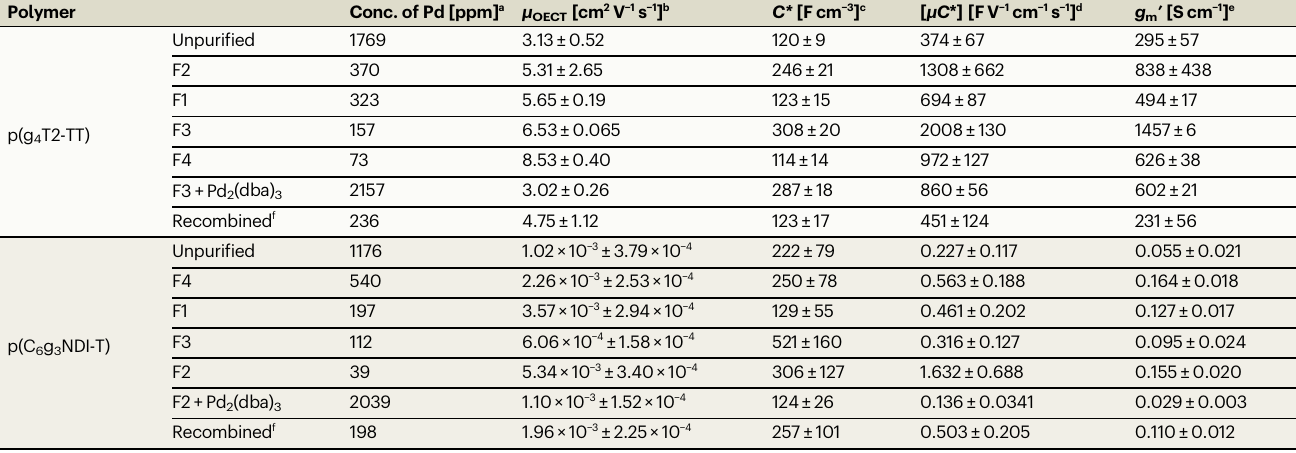
Table 2 | Steady-state OECT performance of polymers Polymer